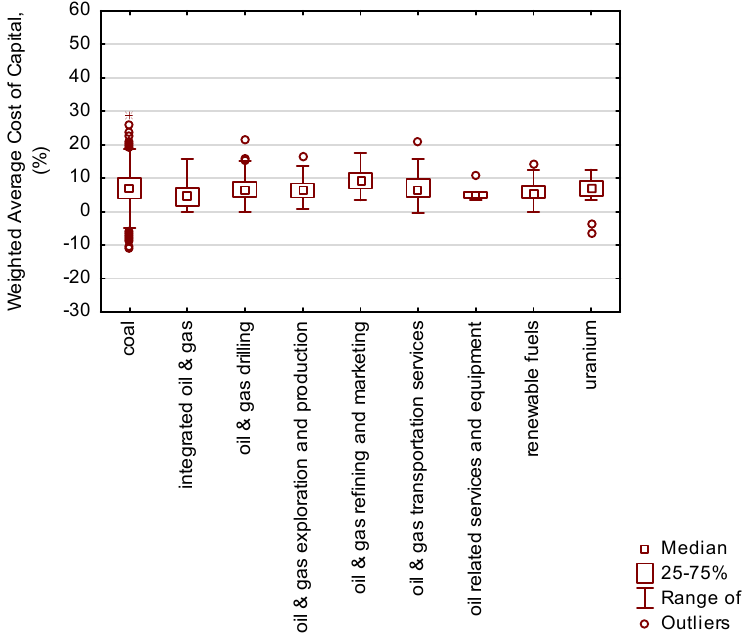
Figure 2. WACC component statistics according to intra-industry WACC component statistics according to intra-industry analysis. 426